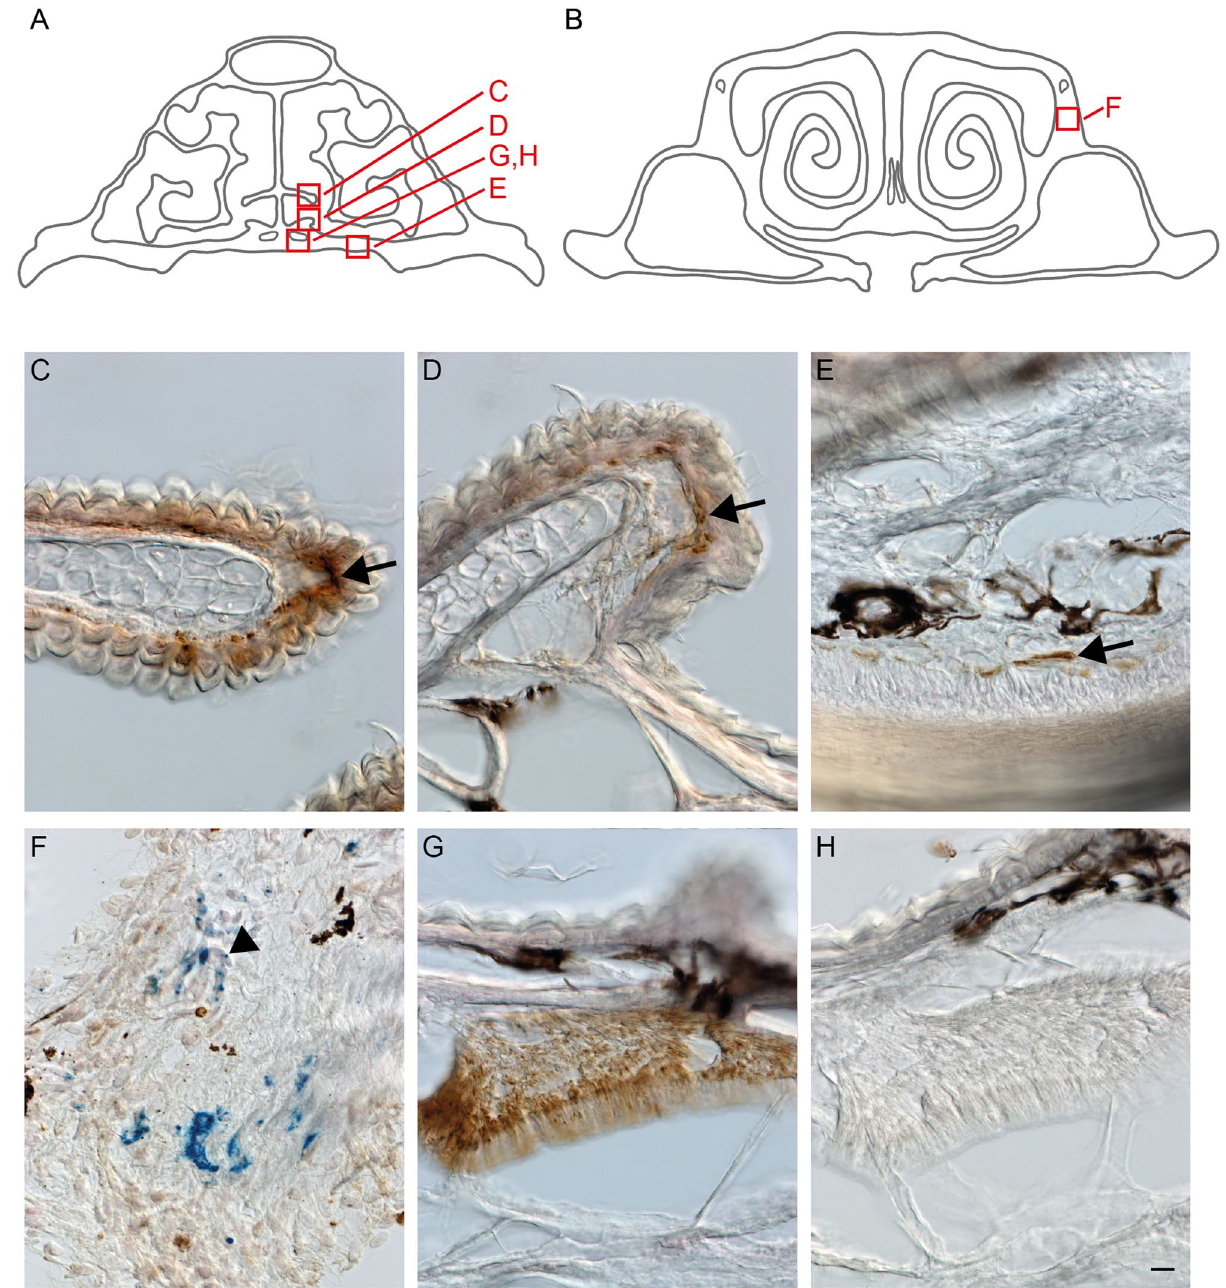
Figure 2. Cholera toxin B subunit labelled fiber terminals of the ophthalmic subbranch of the trigeminal nerve (V1) and Prussian blue labelled structures within the upper beak of Eurasian blackcaps. Upper beaks of Eurasian blackcaps were cut in a frontal plane and labelled with the neuronal tracer Cholera toxin B subunit (brown), Prussian blue (blue) and the nuclear marker nuclear fast red (magenta). ( A , B ) The location of the regions of interest shown in C to H are indicated by red boxes in schematic representations of frontal beak slices at a rostral ( A ) and caudal ( B ) level. Fiber terminals of V1 (indicated by arrows) are located ( C ) in outgrowths of the nasal septum, ( D ) in the ventral subepidermal layer, ( D ) in the bulges of the ventral part of the upper beak, and ( E ) in the ventral subepidermal layer at intermediate beak levels. ( F ) Representative image of PB labelled structures. Arrowheads indicate PB-labelled structures colocalized with nuclear fast red. ( G ) CtB labelling in V1 is shown as positive control and ( H ) the same structure when the primary antibody was omitted as negative control. Black structures in the beak slices represent endogenous pigment of the upper beak. Scale bar: H (for C-H), 10